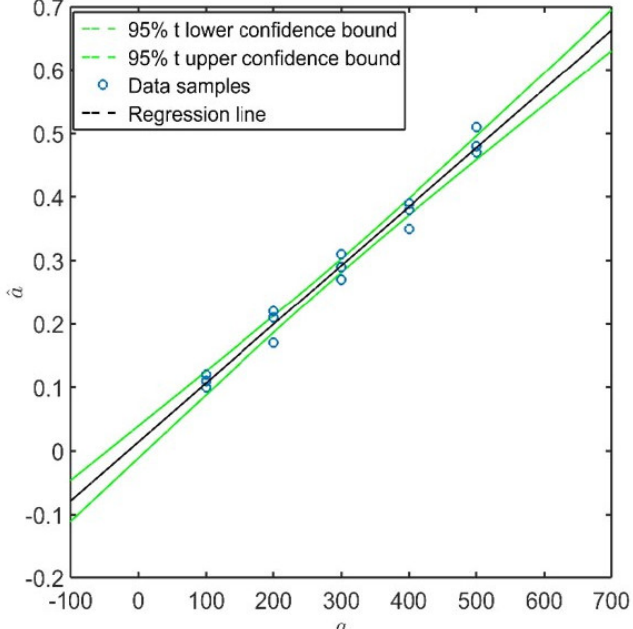
Figure 5. Confidence bounds of the predicted response (illustrative